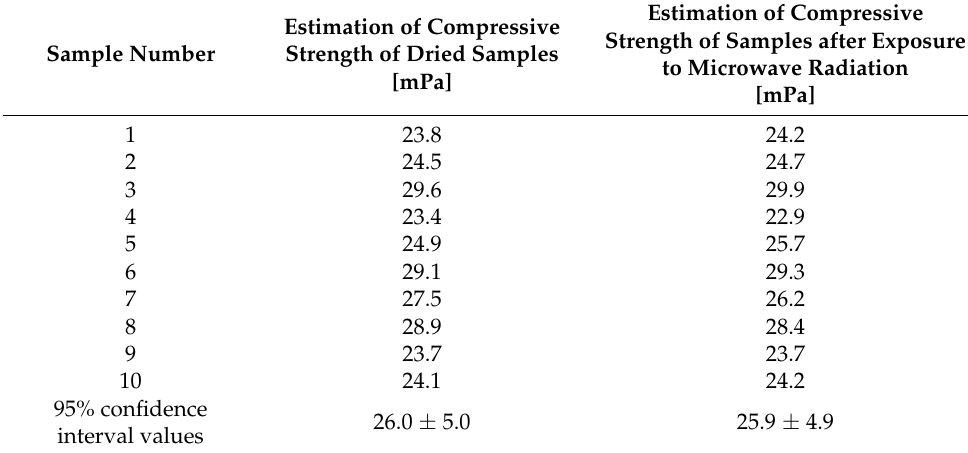
Table 6. Overview of the average passage time of the ultrasonic